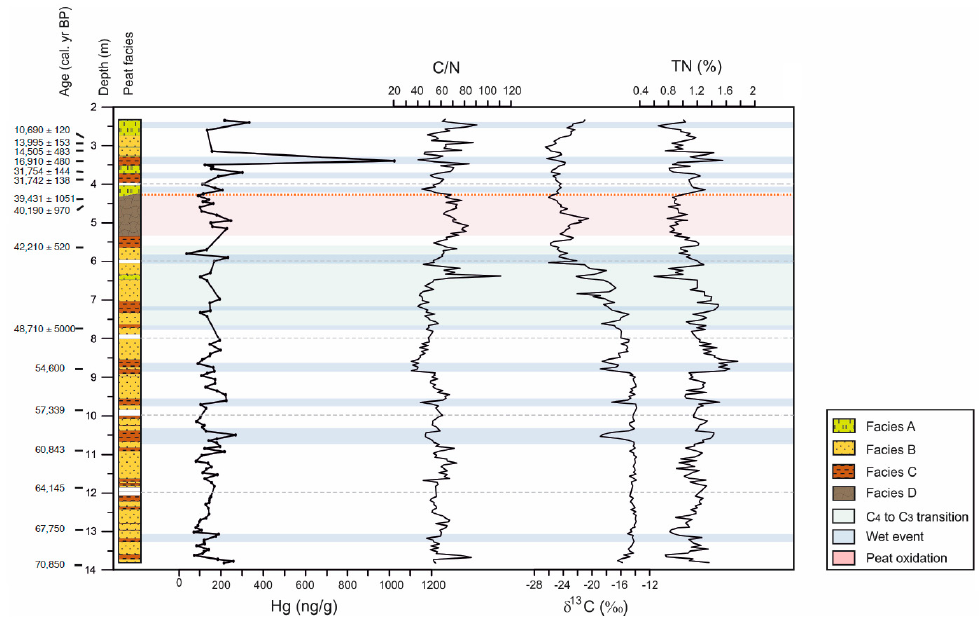
Figure 2. Depth profiles of the main paleoenvironmental proxies and Hg concentration analyzed in the ARO 06 01 core. Lithology and radiocarbon age samples are indicated in the column. Geochemical proxies: total nitrogen and total carbon (TN, C/N) ratios and δ 13 C, are indicative of the origin of organic matter; and δ 13 C (‰) and Facies C [31] are wet event indicators. Periods of wet events and drought conditions are marked.